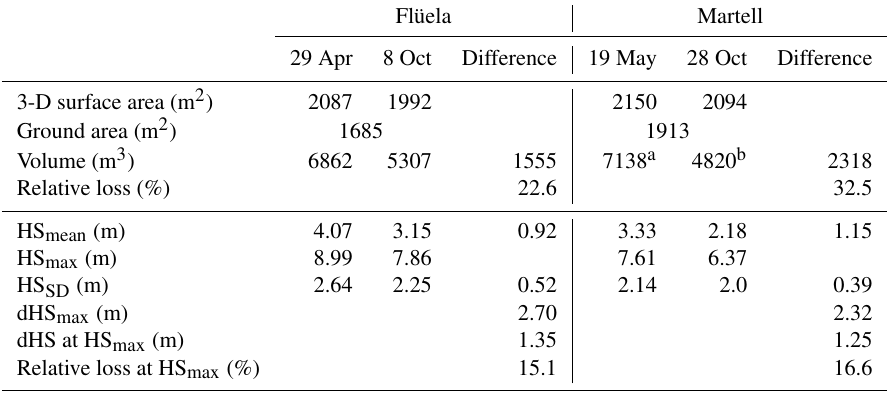
Table 4. Geometric properties and snow depth statistics of the Flüela and the Martell snow heap as calculated from the TLS surveys. HS mean is the mean snow height of the heap, HS max the maximum snow height, HS SD the standard deviation of snow height, dHS max the maximum snow height change and dHS at HS max the snow height change at the location of HS max .